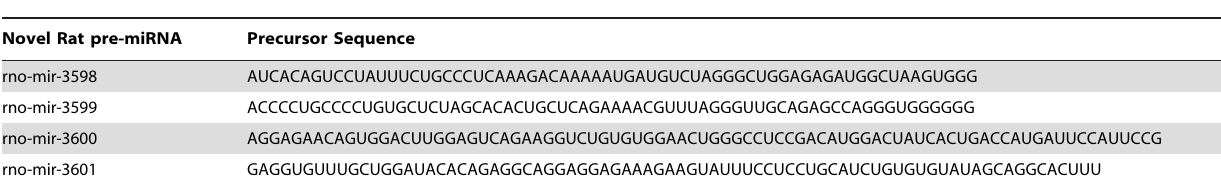
Table 7. Four rat-specific novel pre-miRNAs sequences.